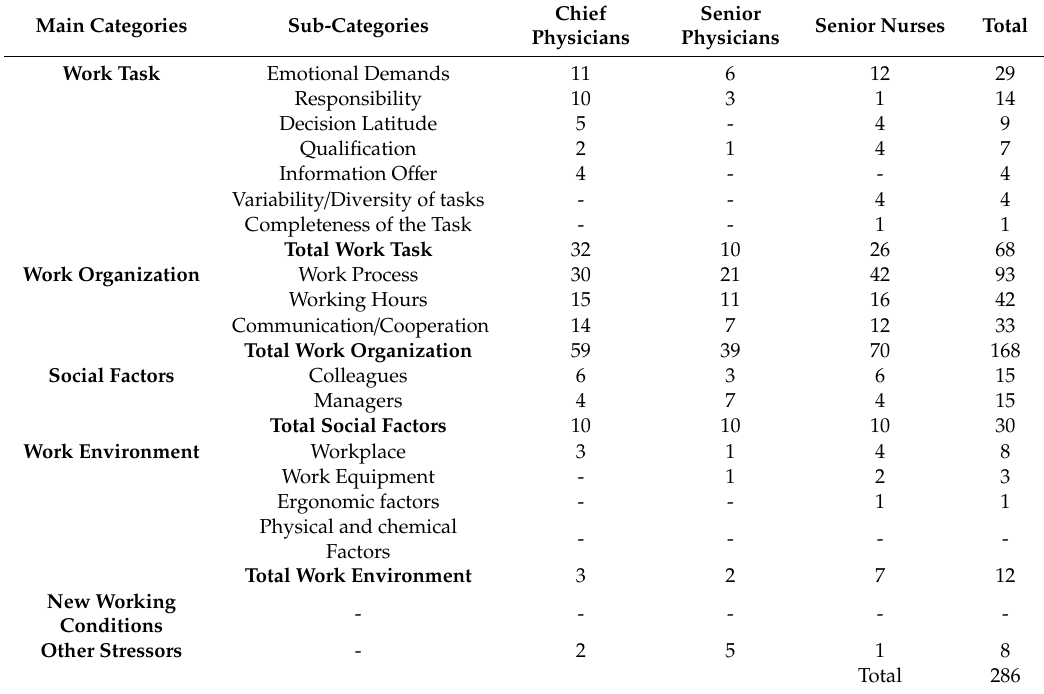
Table A2. Number of mentioned stressors per manager und subcategory.